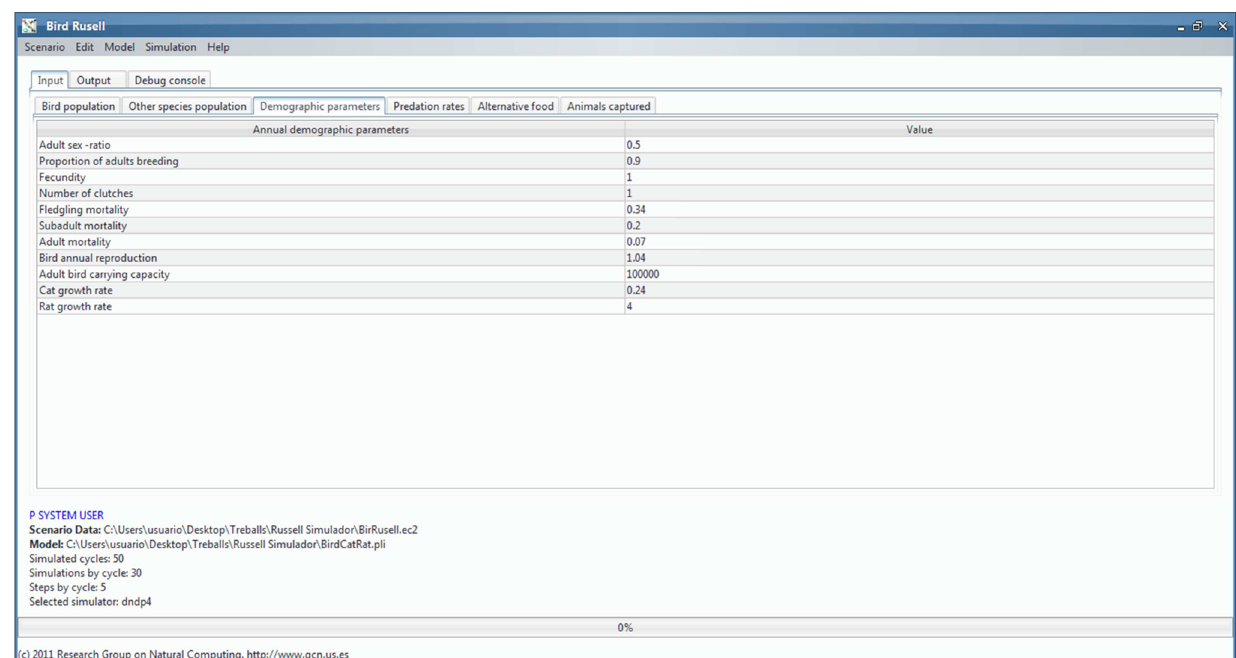
Figure 6. Screen of the simulator obtained using MeCoSim showing the demographic parameters. The user can change the values directly in the simulator placed in the box, which instantly tells us the evolution of the ecosystem by varying the starting scenario.